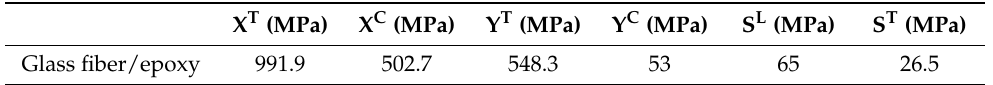
Table 4. Hashin Model